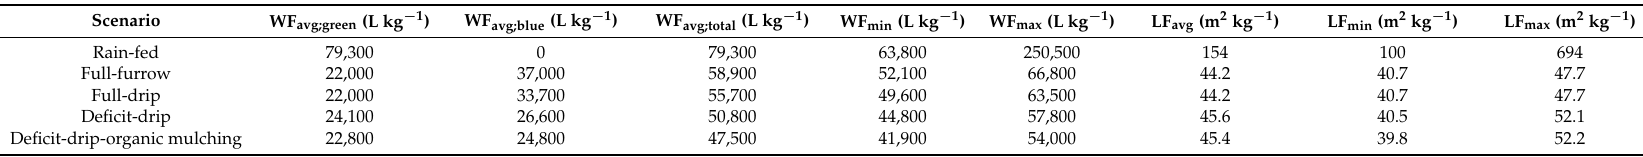
Table 3. Green and blue WF and average, minimum and maximum total WF and LF of raw silk related to mulberry leaf production per kg of raw silk for five different scenarios. Average WF and LF are production weighted over the period